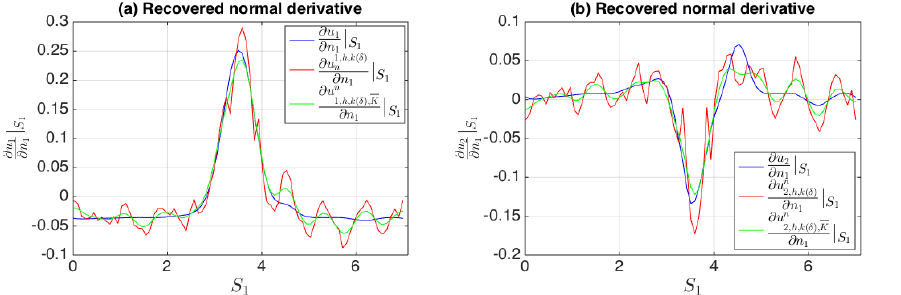
Figure 9. ( a ) Plots of exact normal derivative of u 1 and its approximations with and without sequential smoothing corresponding to input data with error V δ , using mesh M 1 of irregular region. ( b ) Plots of exact normal derivative of u 2 and its approximations with and without sequential smoothing corresponding to input data with error V δ , using mesh M 1 of irregular region.